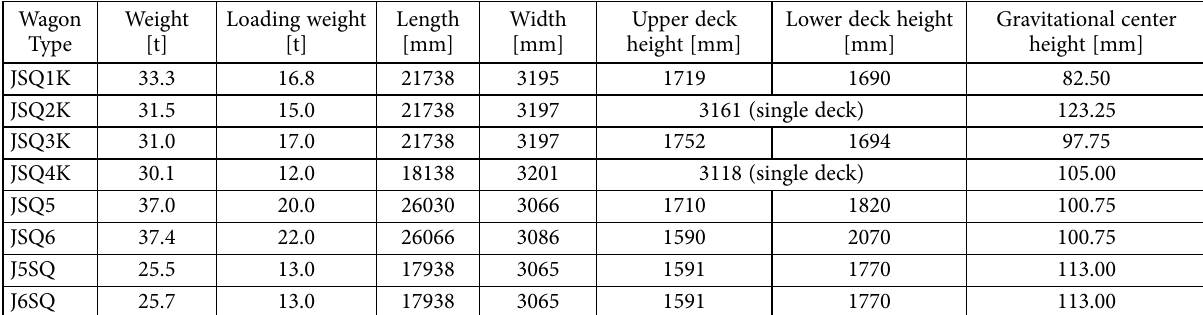
Table 4. Information for the wagons used to motorail in China (Huang, Shuai 2015)